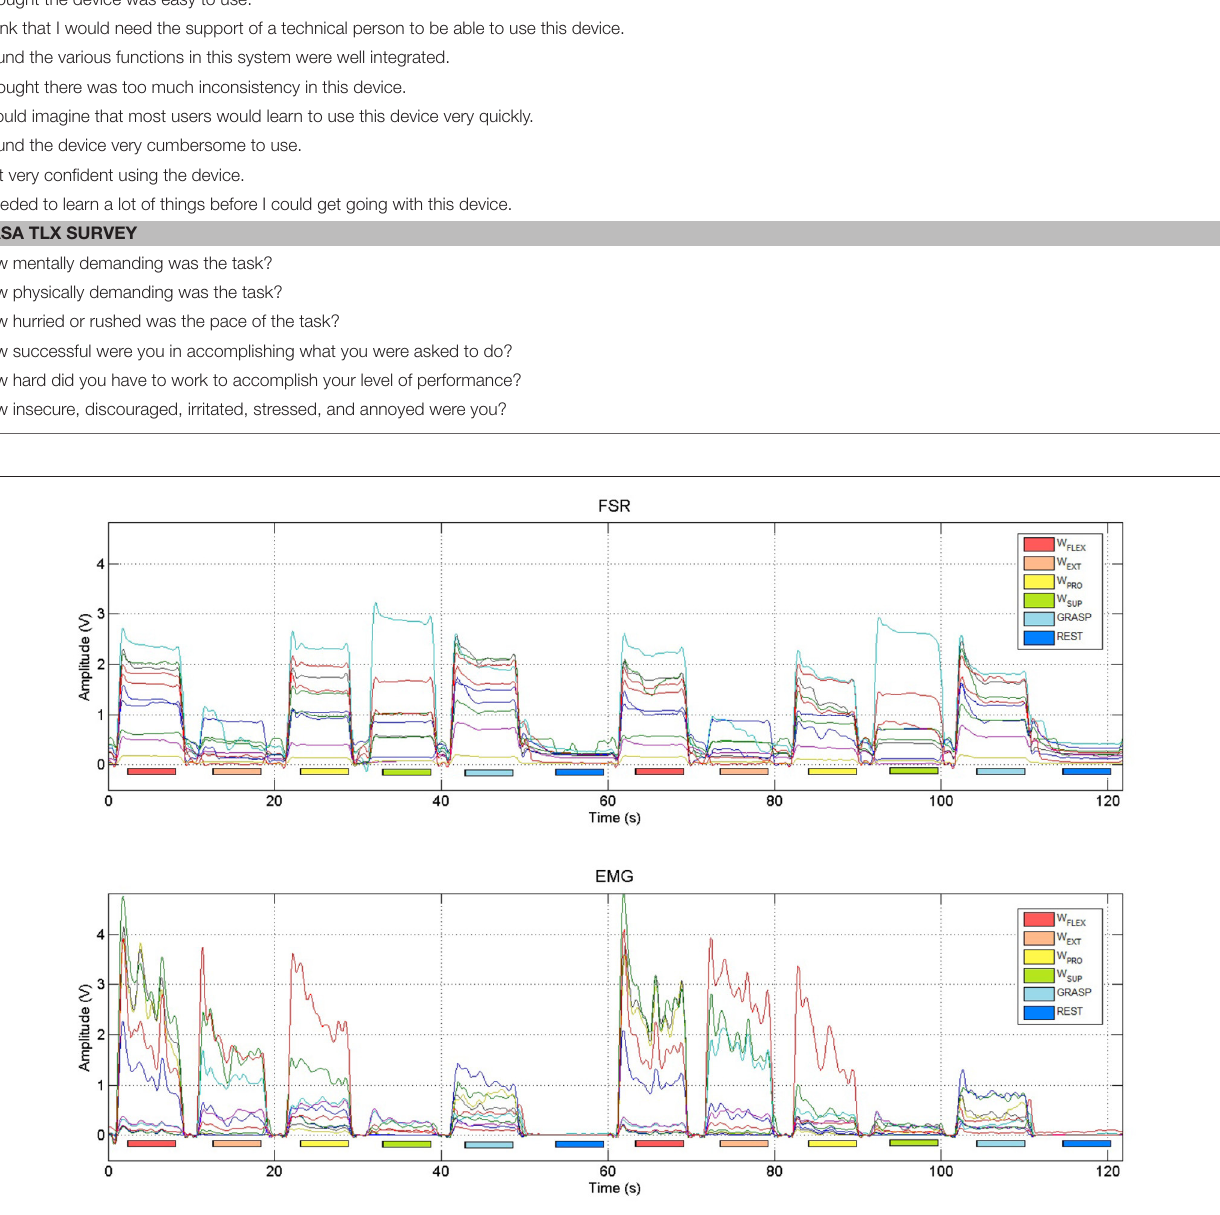
FIGURE 6 | Typical FSR and sEMG signals obtained from two repetitions of the instructed hand and wrist movements (wrist flexion, wrist extension, wrist pronation, wrist supination, power grasp and rest). Colored bars denote the activation phases, during which data were collected to represent the maximal activation of the stimulated